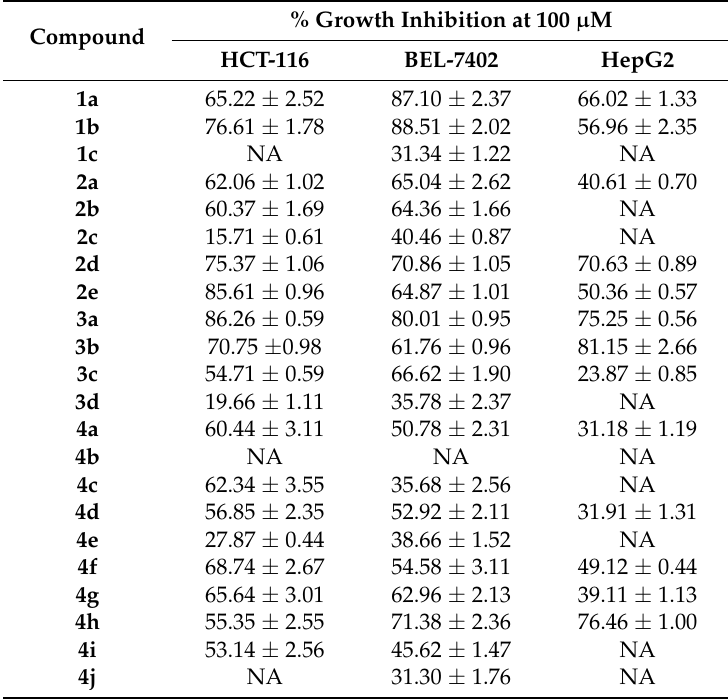
Table 1. The antiproliferative activity of compounds (% Growth Inhibition at 100 µ